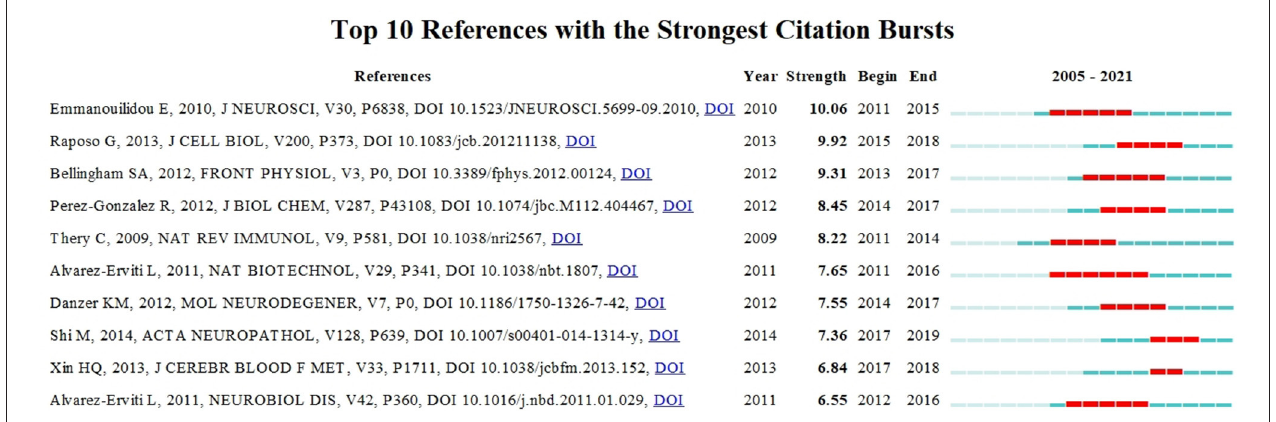
FIGURE 9 | The top 10 references with the strongest citation bursts on exosomes in the field of neuroscience during 2005–2021.